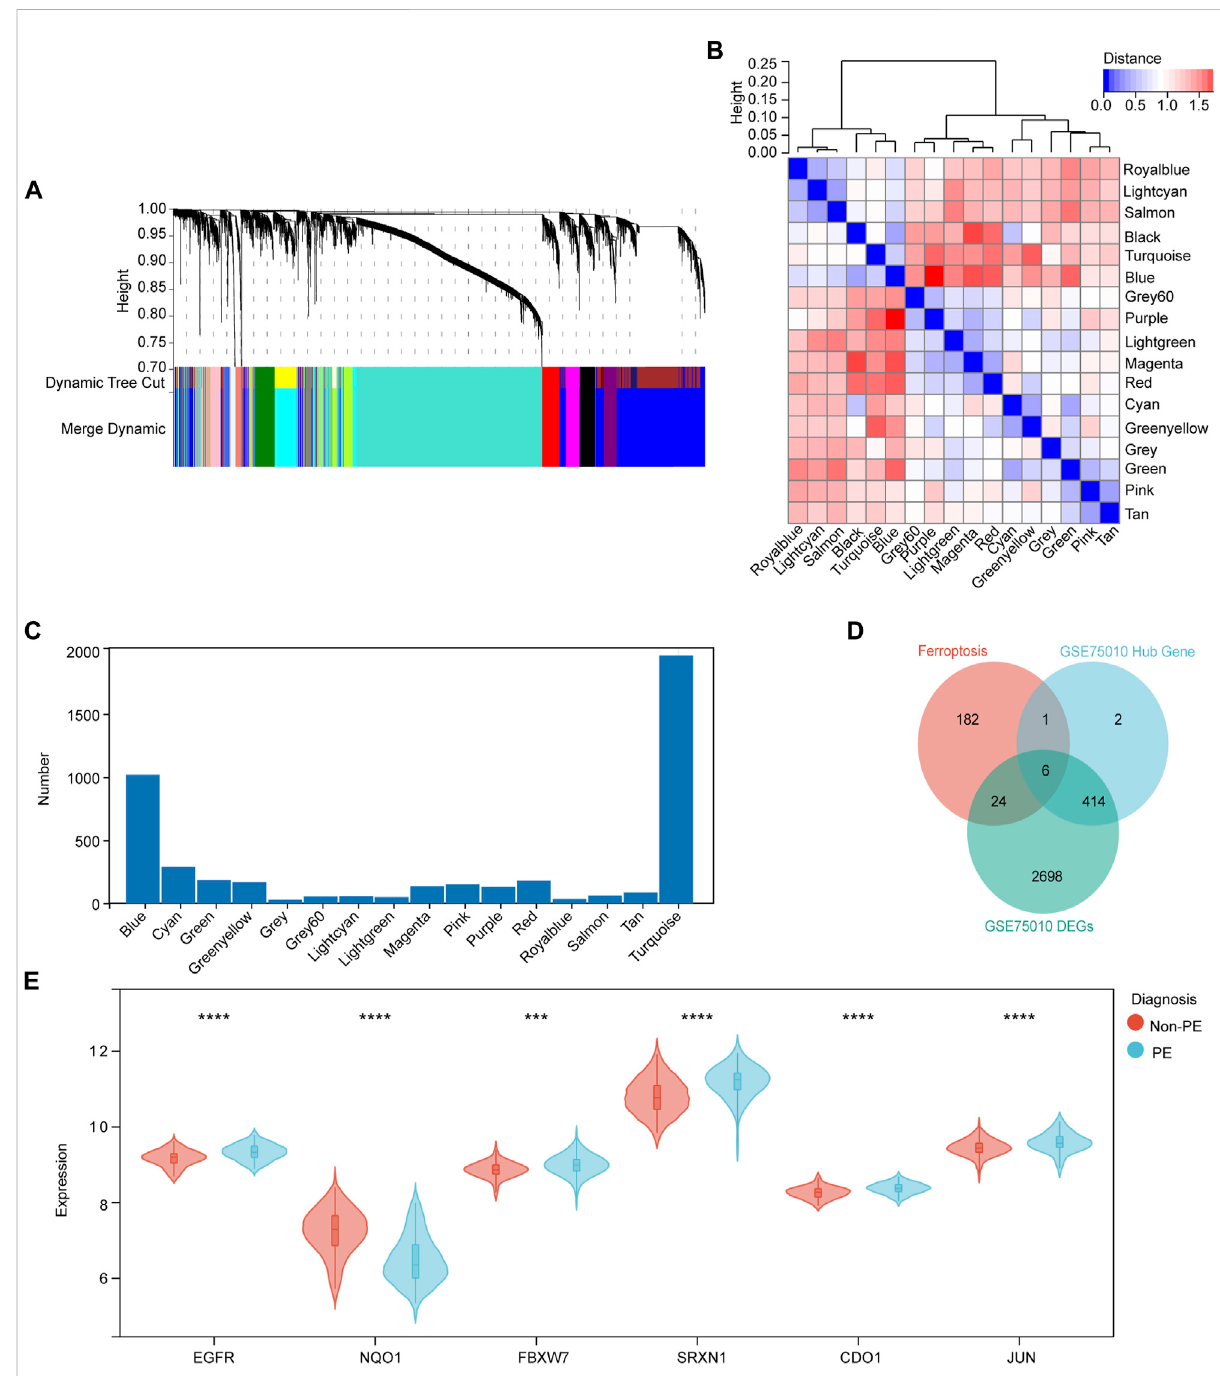
FIGURE 4 Identi fi cation of candidate ferroptosis-related hub genes in the placenta of preeclampsia. (A) Dendrogram of all genes clustered based on a dissimilarity measure (1- TOM). Each branch represents a gene and each color represents a co-expression module. (B) Module eigengene dendrogram andheatmapofeigengeneadjacency. (C) Numberofgenesineachco-expression module. (D) Venndiagramshowscommon genesin the three gene sets. (E) Violin plot showing expression levels of six hub genes in non-PE and PE women. * p < 0.05, ** p < 0.01, *** p < 0.001, **** p <